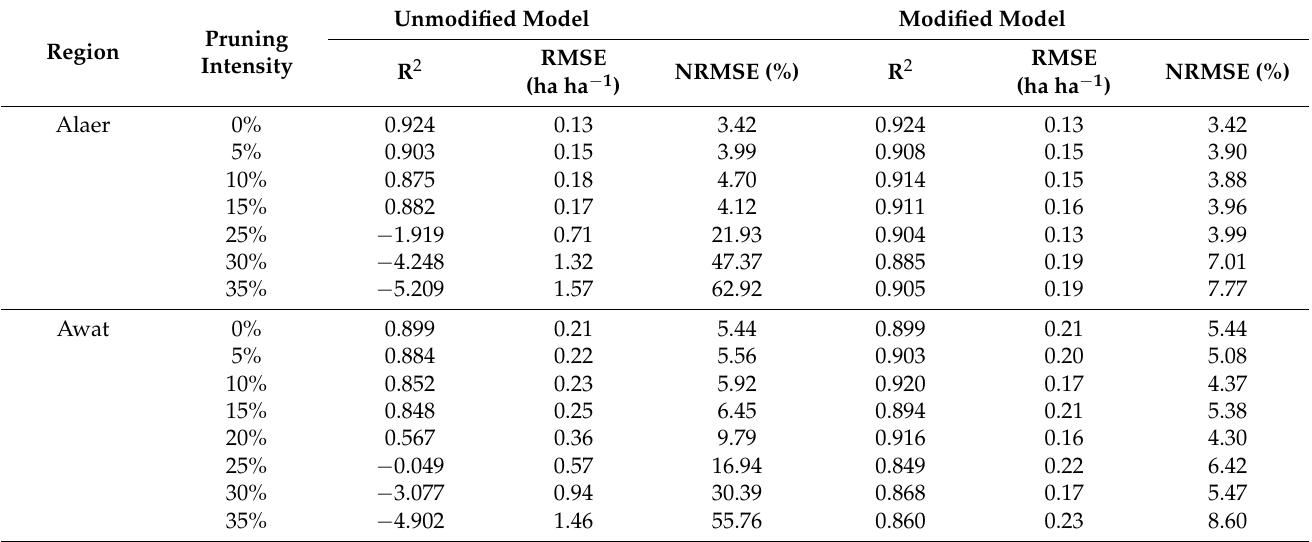
Table 3. Simulated LAI validation for different treatments.